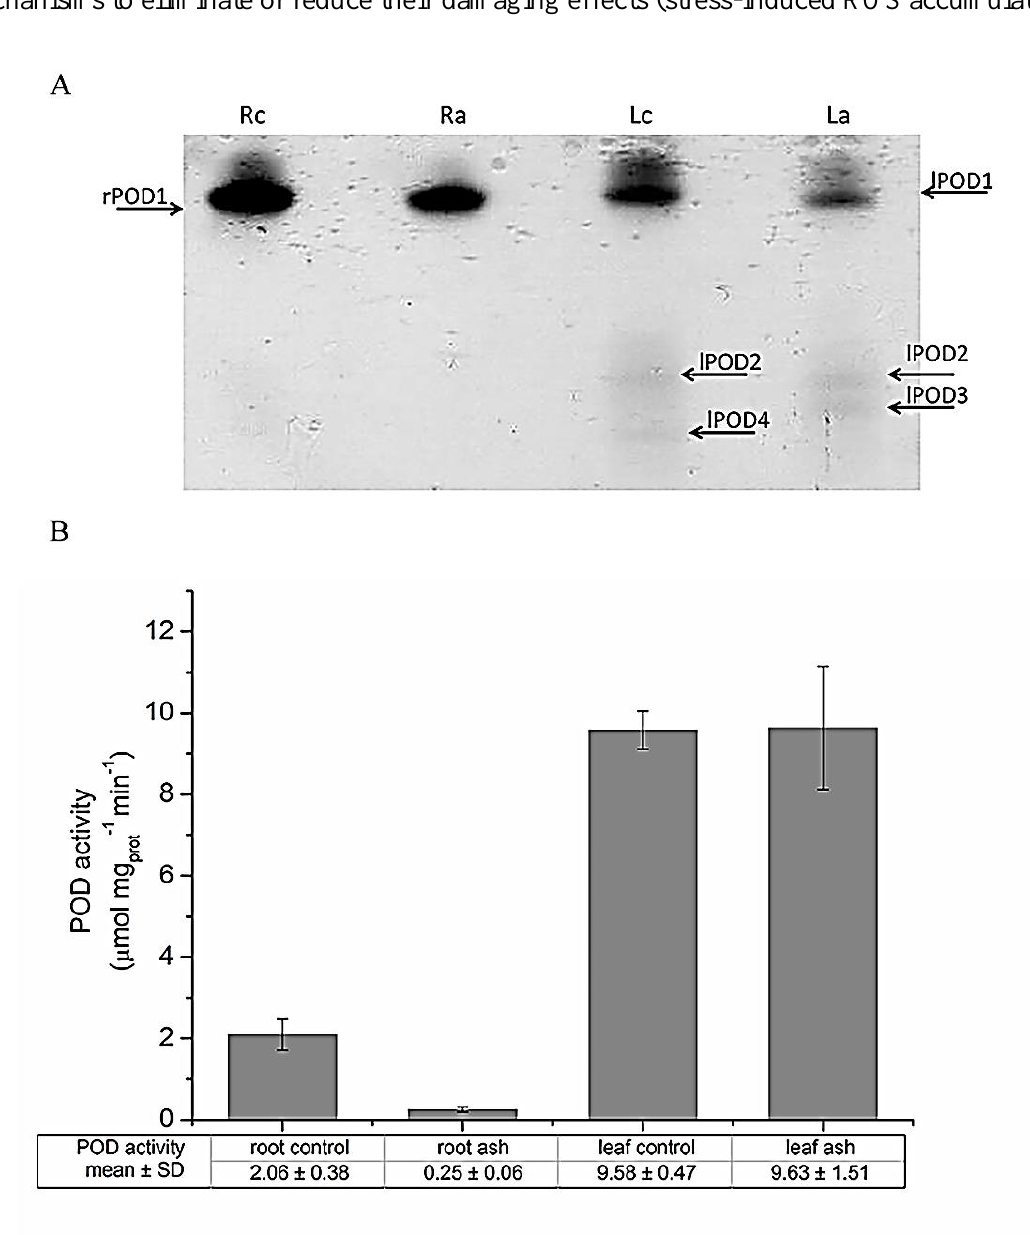
Figure 2. A) Native gel with POD isoforms detected with specific α-chloro-naphthol staining. The arrows indicate the different POD isoforms: in root samples rPOD1 and lPOD1, lPOD2, lPOD3 and lPOD4 in leaf samples. B) Peroxidase activity were determined spectrophotometrically by measuring the increase in absorbance at 430